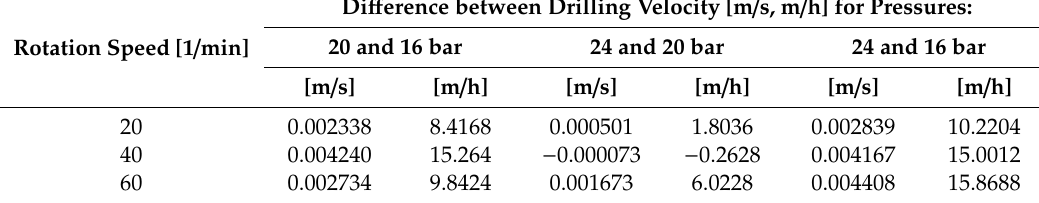
Table 7. Di ff erences between drilling velocity measured for various air pressures and drill rotation speeds of the 140 mm diameter drill bit, in the interval 54–72 m below ground level.